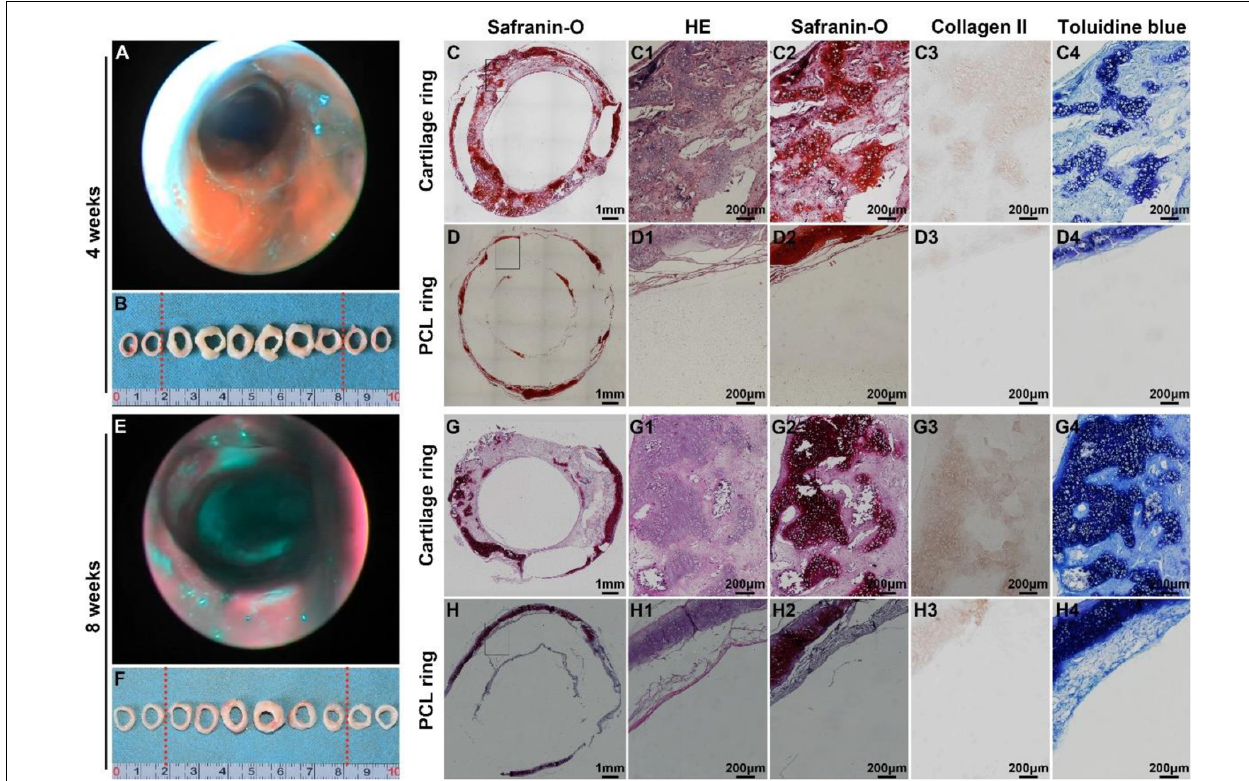
FIGURE 8 | Therapeutic outcome after tracheal replacement. Bronchoscopy and gross examination images of the biomimetic trachea 4 weeks after the replacement surgery (A,B) . Histological images of a transverse section of the biomimetic trachea showing a cartilage ring (C,C1–C4) and a PCL ring (D,D1–D4) 4 weeks after the replacement surgery. Bronchoscopy and gross examination images of the biomimetic trachea 8 weeks after the replacement surgery (E,F) . Histological images of a transverse section of the biomimetic trachea showing a cartilage ring (G,G1–G4) and a PCL ring (H,H1–H4) 8 weeks after the replacement surgery. The biomimetic trachea is delineated by red dotted lines.